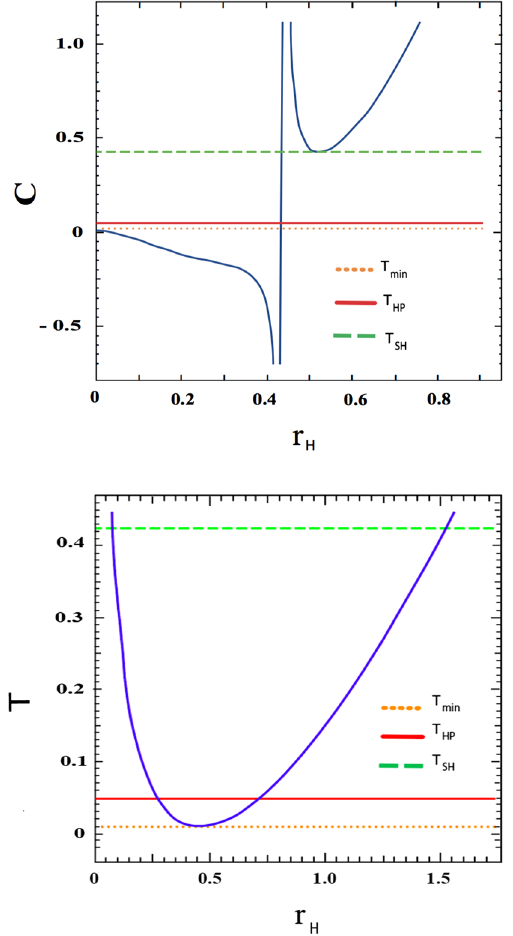
Fig. 6 Graphs of C × r H (up panel) and of T × r H (down panel) for positive cosmological constant, with T min = 0 . 00910104338, T HP = 0 . 049474913904 and T SH = 0 . 42359355918. The curve gives us (cid:2) = 0 . 5 and N = 1 .